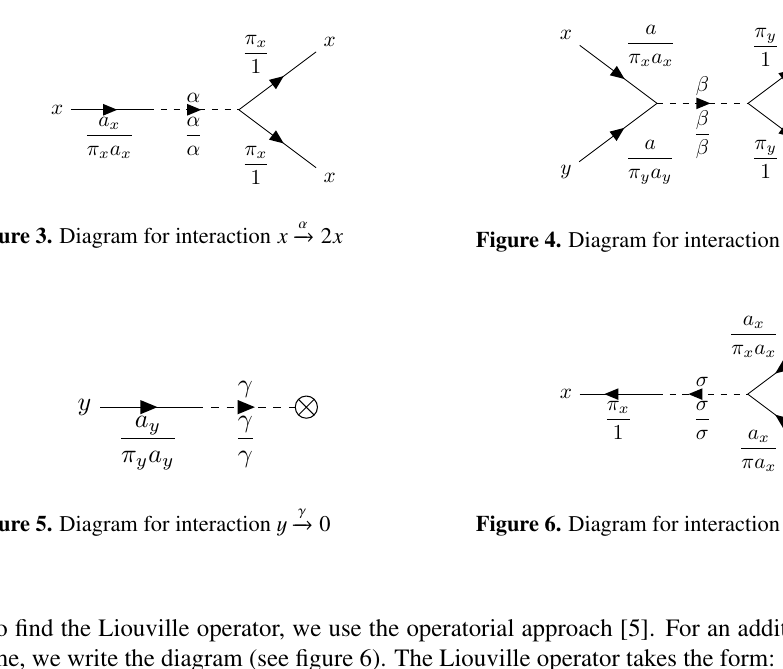
Figure 1. The phase trajectory of the closed sys- tem